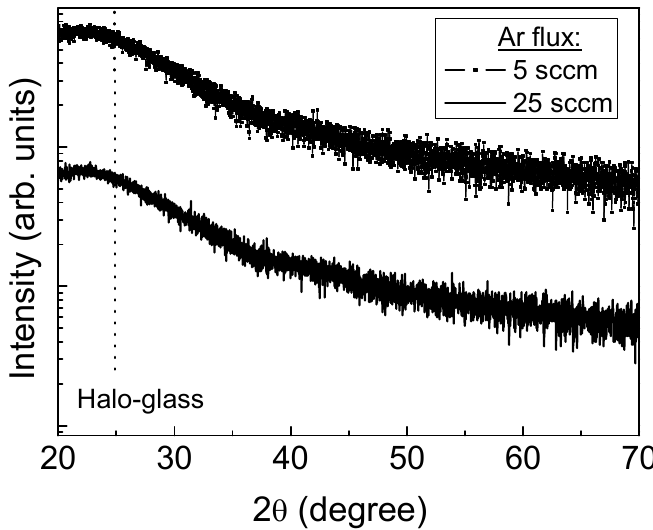
Figure 1. GI-XRD scans of the TiO 2 thin films deposited on glass at different Ar gas fluxes.